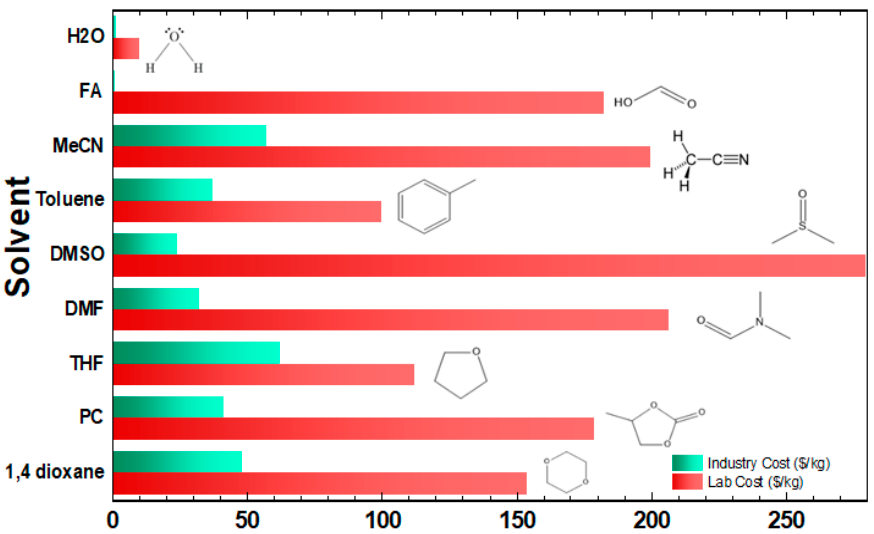
Figure 14. Comparison of the lab-scale and industrial-scale cost of selected solvents for the FA dehydrogenation.